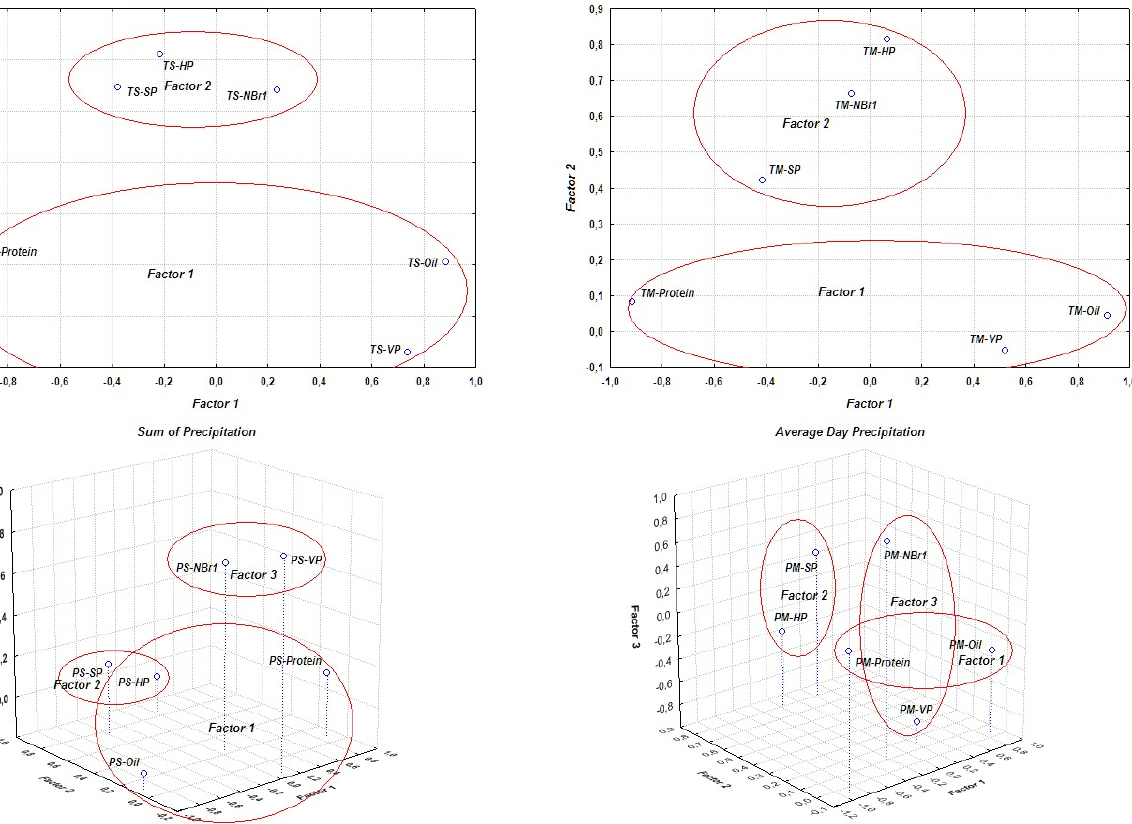
Figure 5. Factor structure of variation of the studied characters by the value of the regression coefficients “trait × environment parameter”.